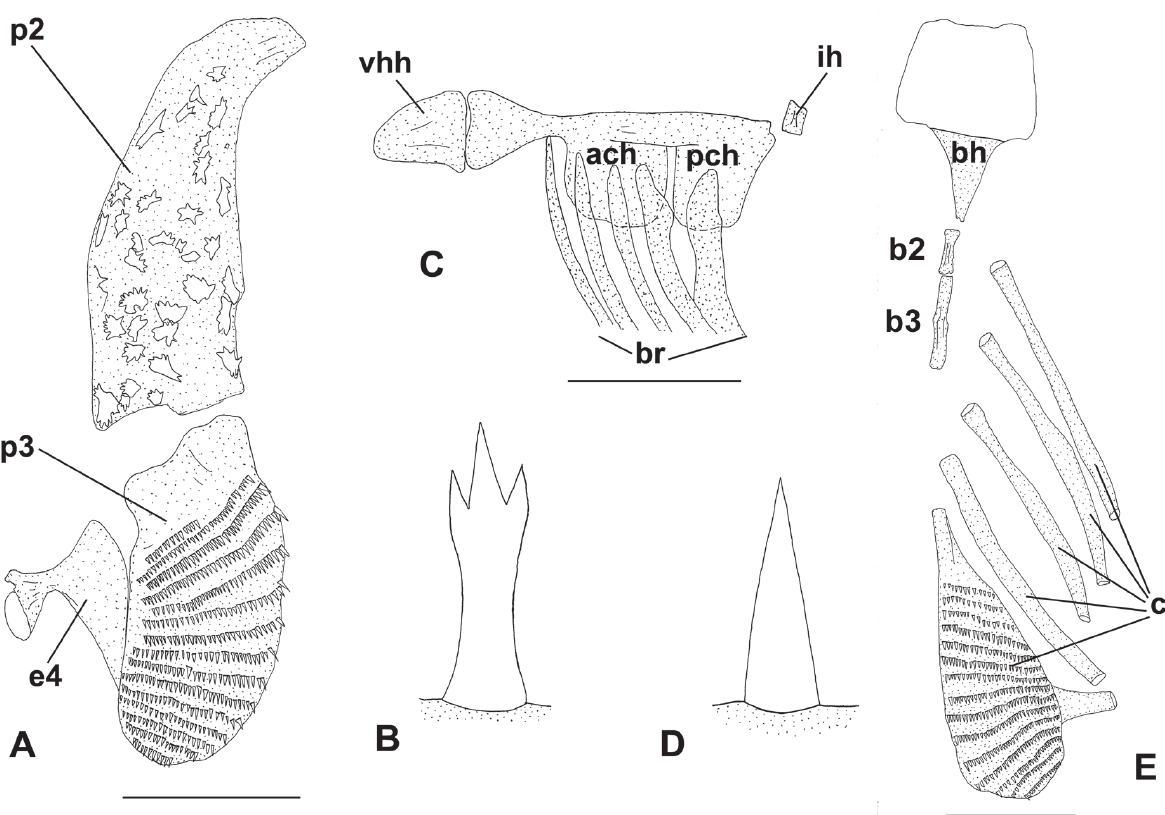
Figure 3. Branchial arches of Pantanodon stuhlmanni : A , left branchial arches, ventral view of dorsal portion; B , third pharyngo- branchial tooth, frontal view; C , left hyoid bar, lateral view; D , fifth ceratobranchial tooth, frontal view; E , left and middle branchial arches, dorsal view of ventral portion. Abbreviations: ach, anterior ceratohyal; b1–2, basibranchials 1–2; bh, basihyal; br, branchios - tegal rays; c, ceratobranchials; e4,fourth epibranchial; ih, interhyal; p2-3, pharyngobranchials 2 and 3, pch, posterior ceratohyal; vhh, ventral hypohyal. Scale bar = 1mm. Figure 3B and 3D are schematic illustrations of the teeth, thus no scale bar is presented. The cartilaginous hypobranchials are not illustrated in Figure